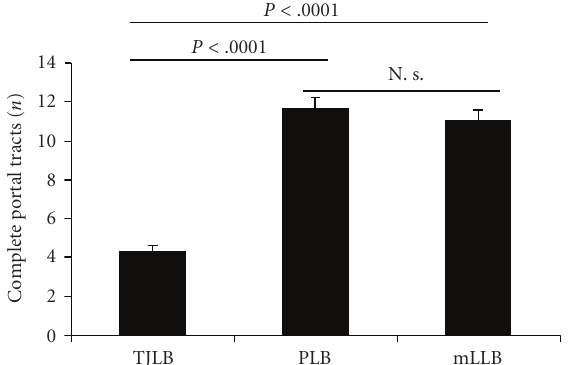
Figure 1: Biopsy quality . Significantly more portal tracts were detected in PLB and MLLB if compared to TJLB.